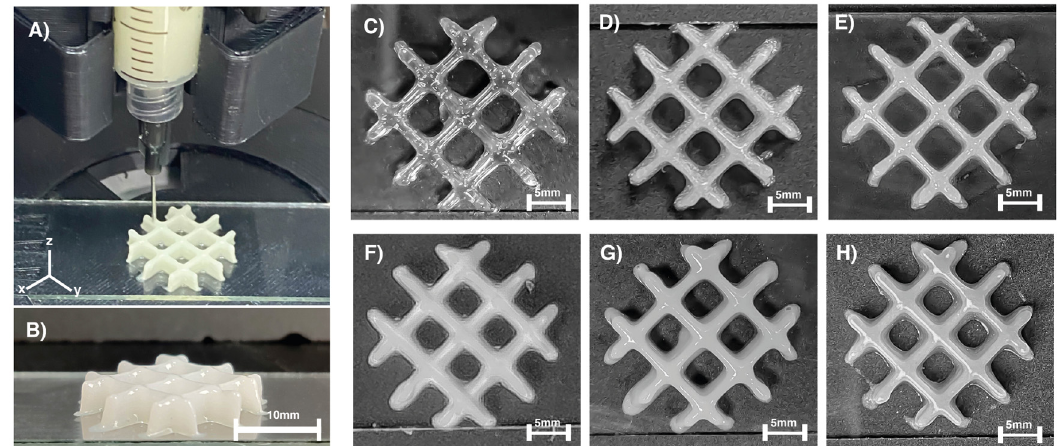
Figure 4. Extrusion of alginate-gelatin samples ( A ) Isometric view of the 3D printed structure; ( B ) lateral view; ( C ) AG1 (control); ( D ) AG2 (Al 2 O 3 ); ( E ) AG3 (Na 2 Ti 6 O 13 ); ( F ) AG4 (TiO 2 ); ( G ) AG5 (ZrO 2 ); and ( H ) AG6 (WO 3 ).